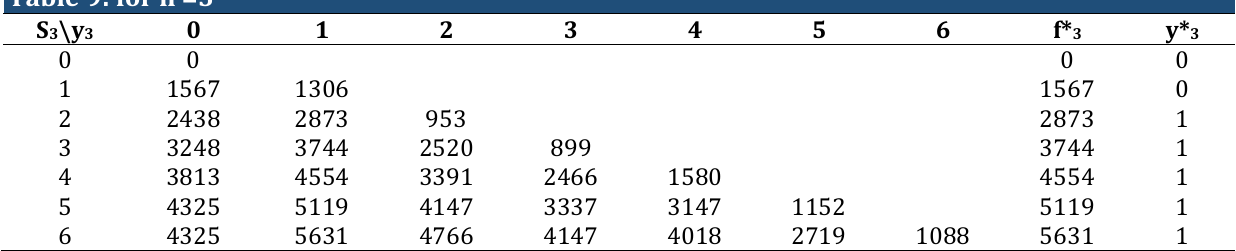
Table 9: for n =3